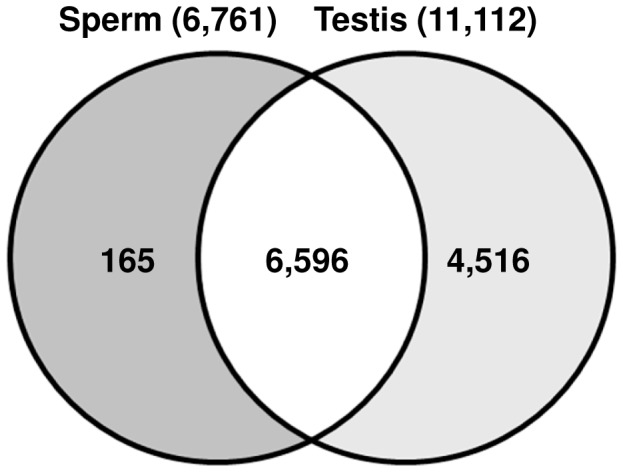
Venn diagram of transcripts detected in stallion sperm and testes by microarray analysis (SNR ≥2).